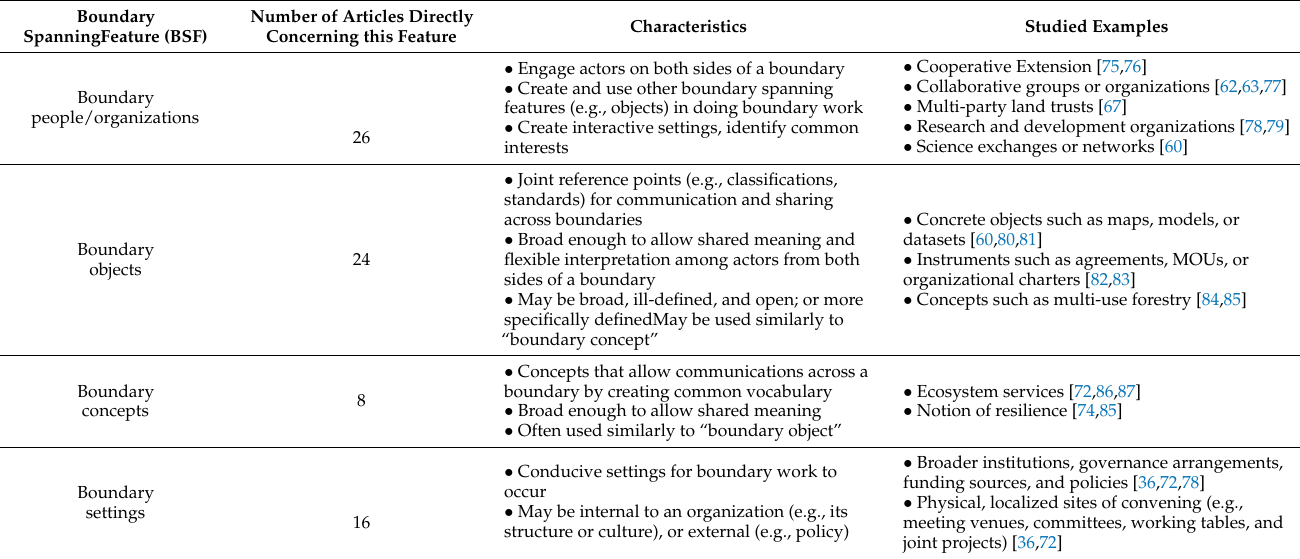
Table 2. Summary of commonly recognized boundary spanning